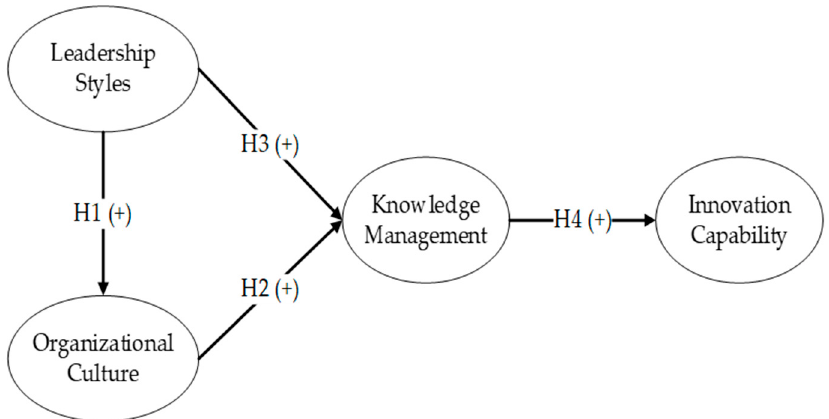
Figure 1. Research model.